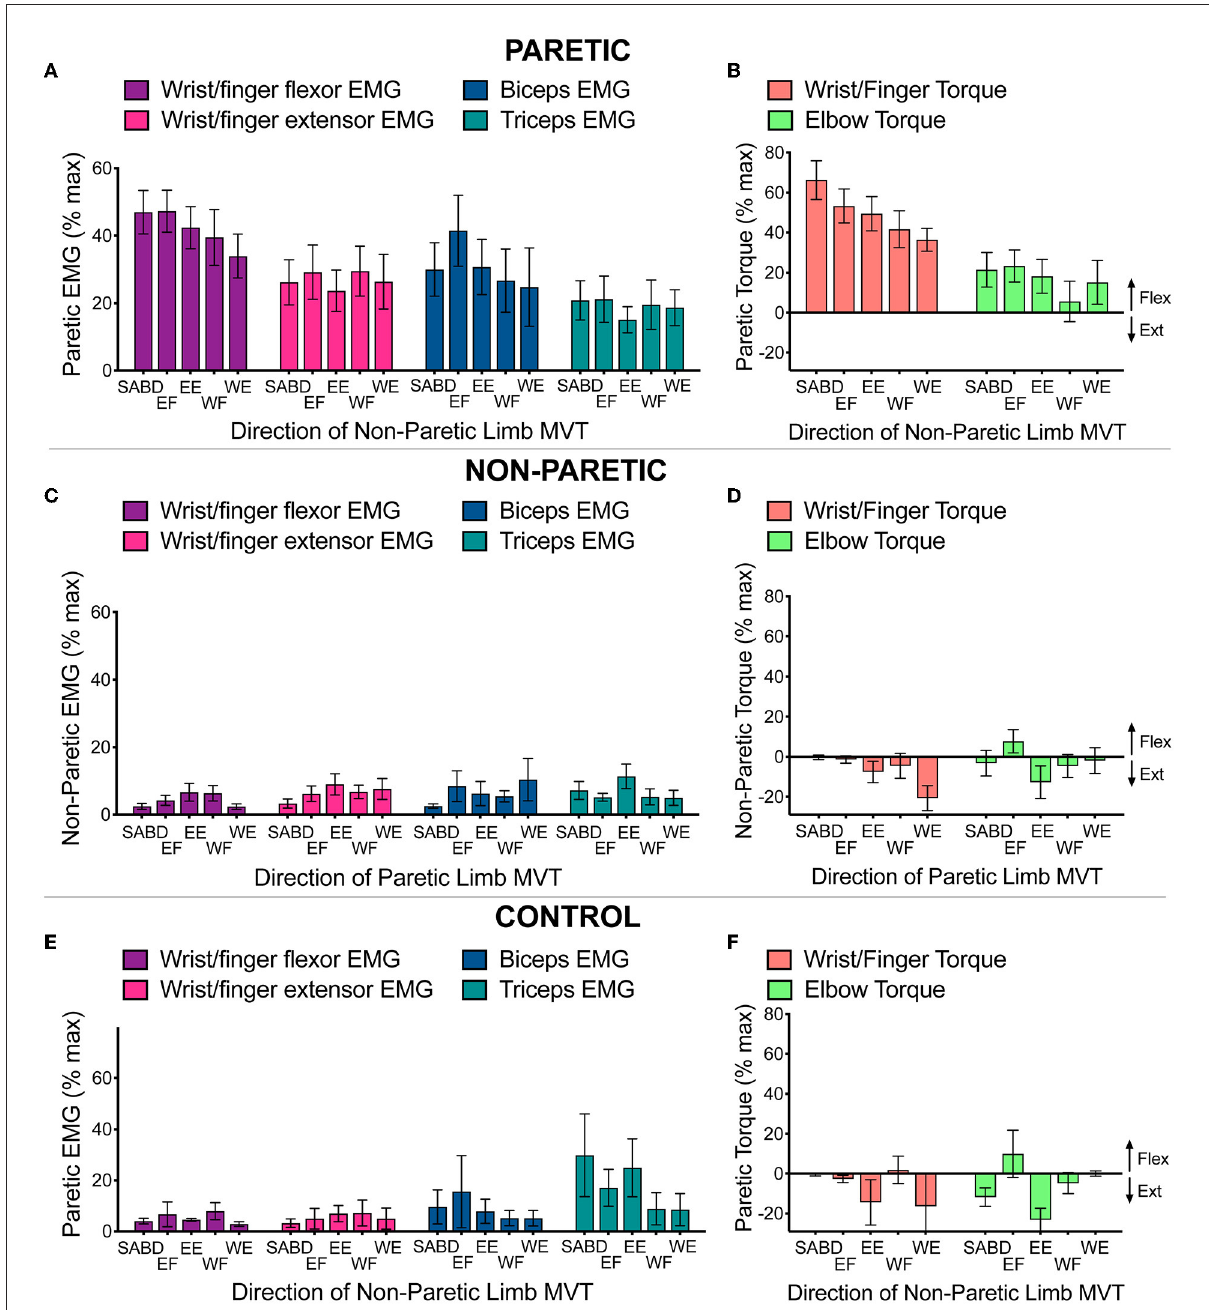
FIGURE5 Voluntary strength deficit in torque (A,C,E) and voluntary activation deficit in EMG (B,D,F) for the paretic (A,B) , non-paretic (C,D) , and control (E,F) limbs during maximal voluntary efforts by the contralateral limb in SABD, EF, EE, WF, and WE directions. Values shown are based on the actual data, not the linear mixed effect model estimated values that are presented in the text. Outlier elbow torque data from the paretic limb of one participant who demonstrated near maximal levels of elbow extension torque is not shown (see text for details).